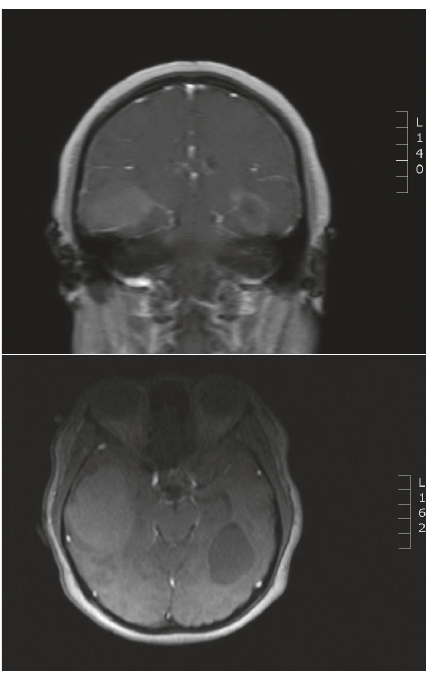
Figure 1: MRI of the brain was done which revealed 4 masses with 2 dominant mass lesions (6.0 and 4.5 cm) having irregular lobulations in the bilateral temporal lobes consistent with metastatic disease.